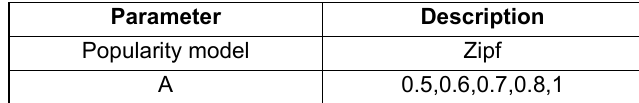
Table 2. Experimental environment; parameters